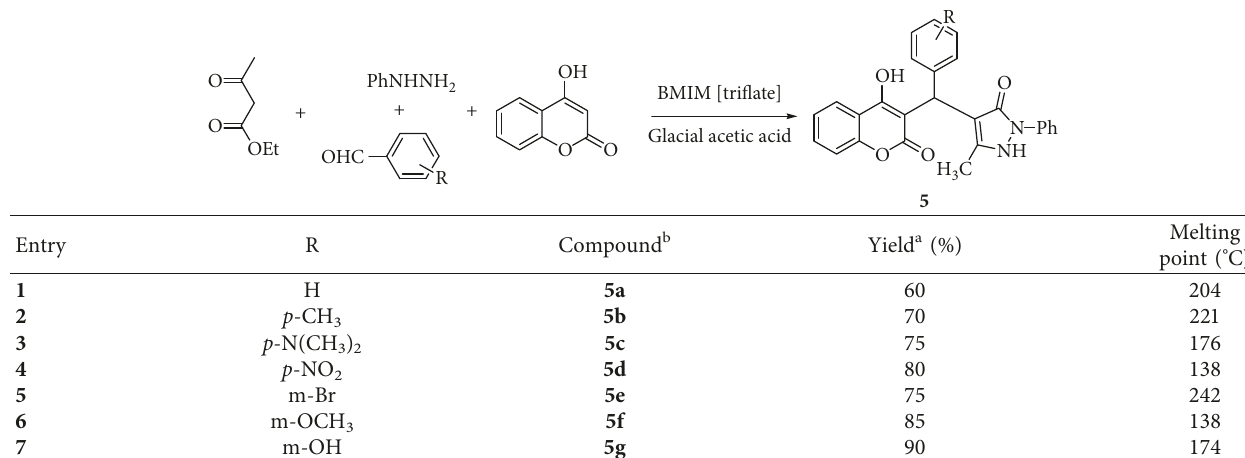
Table 2: Chemical yields and physical properties of coumarins derivatives 5a –5 g .